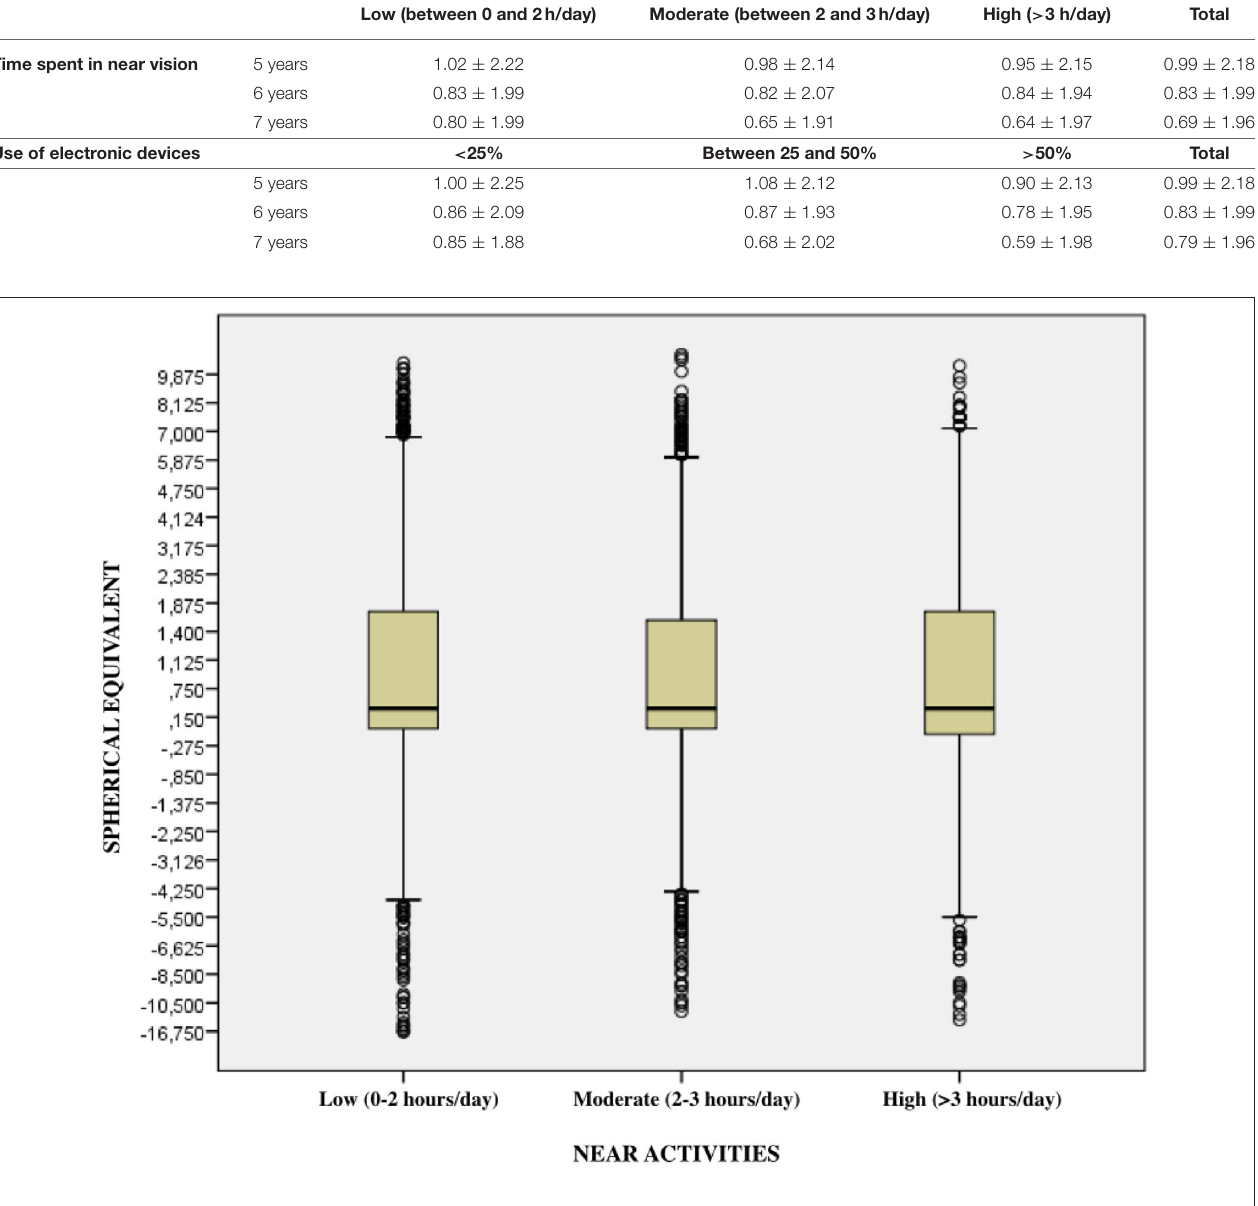
FIGURE 2 | Relationship between near work and the magnitude of refractive error (EE).